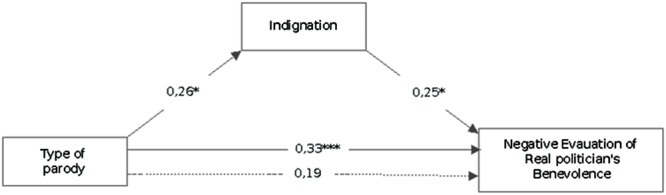
Mediational regression analyses of type of video and indignation on negative evaluation of character’s benevolence. The type of Video variable was processed as a progressive number 1 = imitation, 2 = surface, 3 = deep associated to the progressive “severity of parody,” so the positive relation must be read as follows: when “severity of parody” increases indignation increases too ∗p < 0.05; ∗∗∗p < 0.001. Solid lines between variables denote direct paths between two variables. Dotted lines denote paths when moral and negative emotions are included as mediator. Values denote standardized Beta weights.